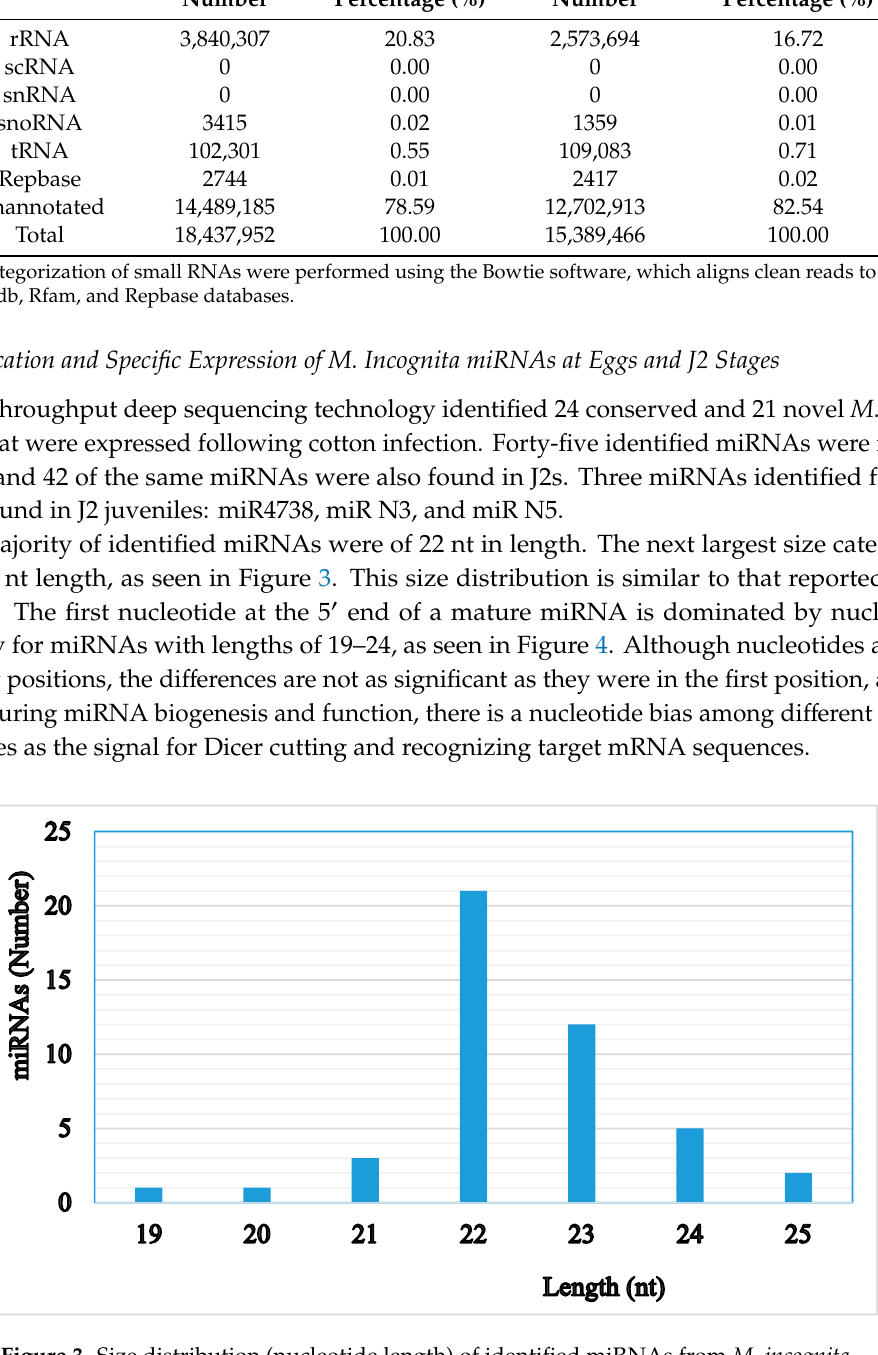
Table 2. Categorization of small RNAs sequenced in eggs and J2 larvae *.